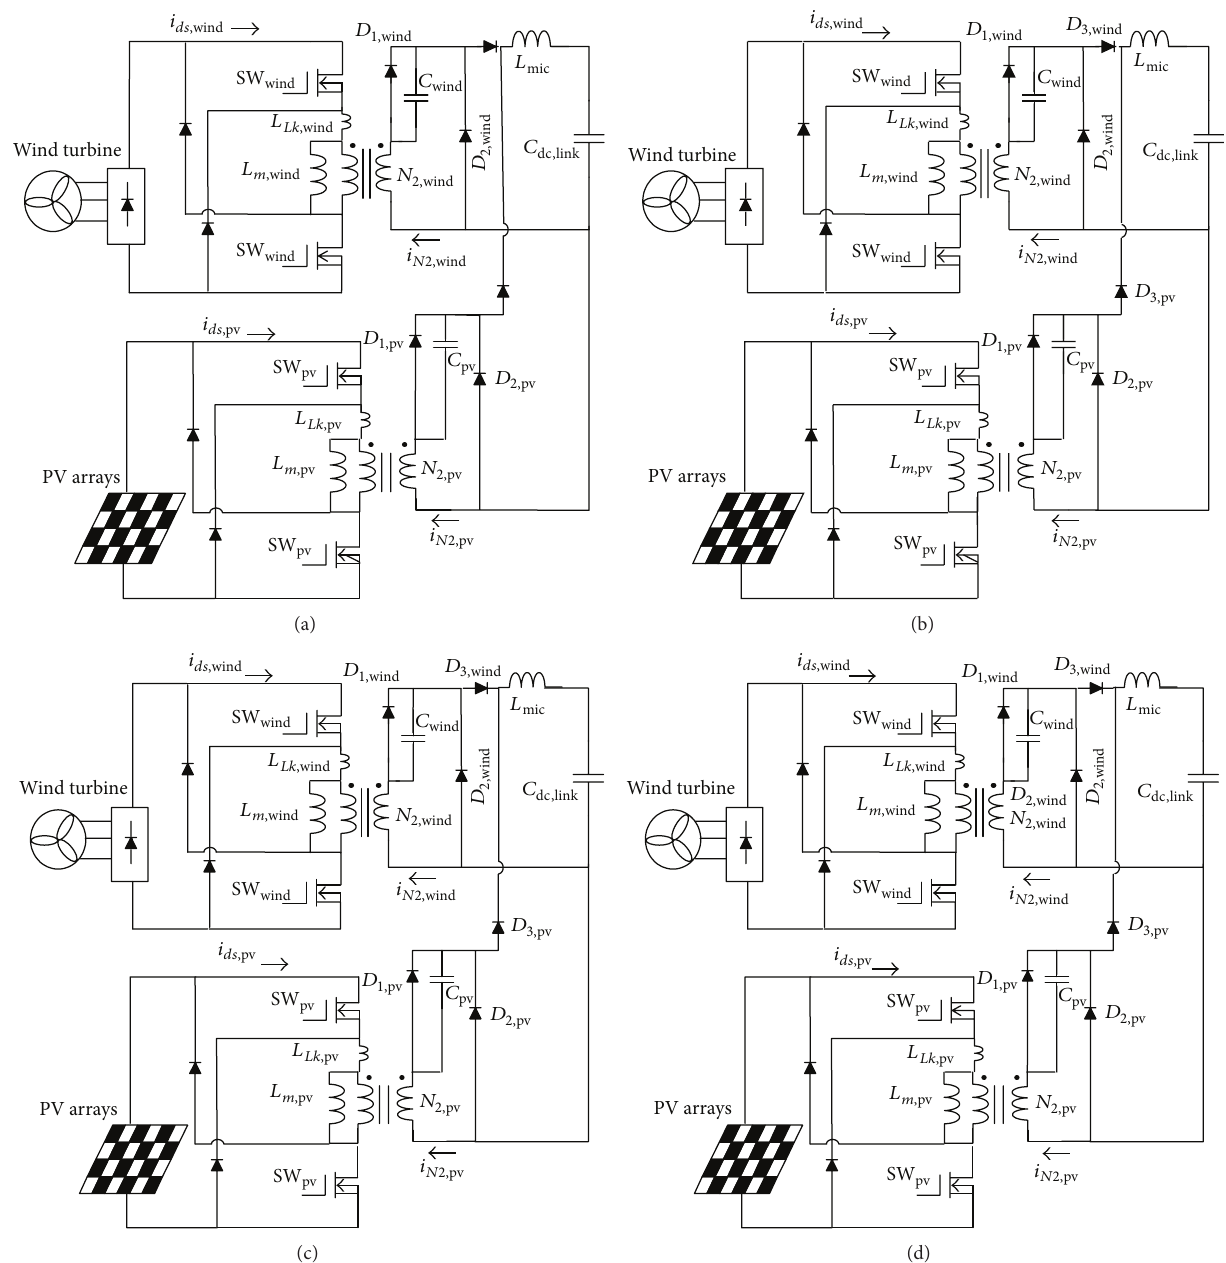
Figure 7: Equivalent circuits of the MIC corresponding to the four operation modes over one switching cycle: (a) Mode 1, (b) Mode 2, (c) Mode 3, and (d) Mode